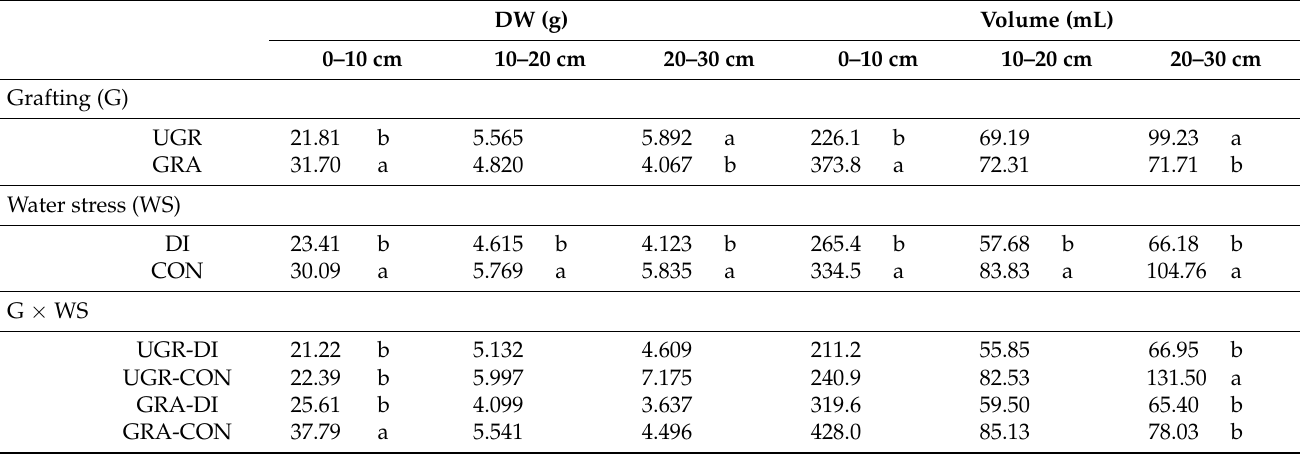
Table 4. Distribution of dry biomass and root volume for grafting (GRA and UGR) and water stress factors (CON and